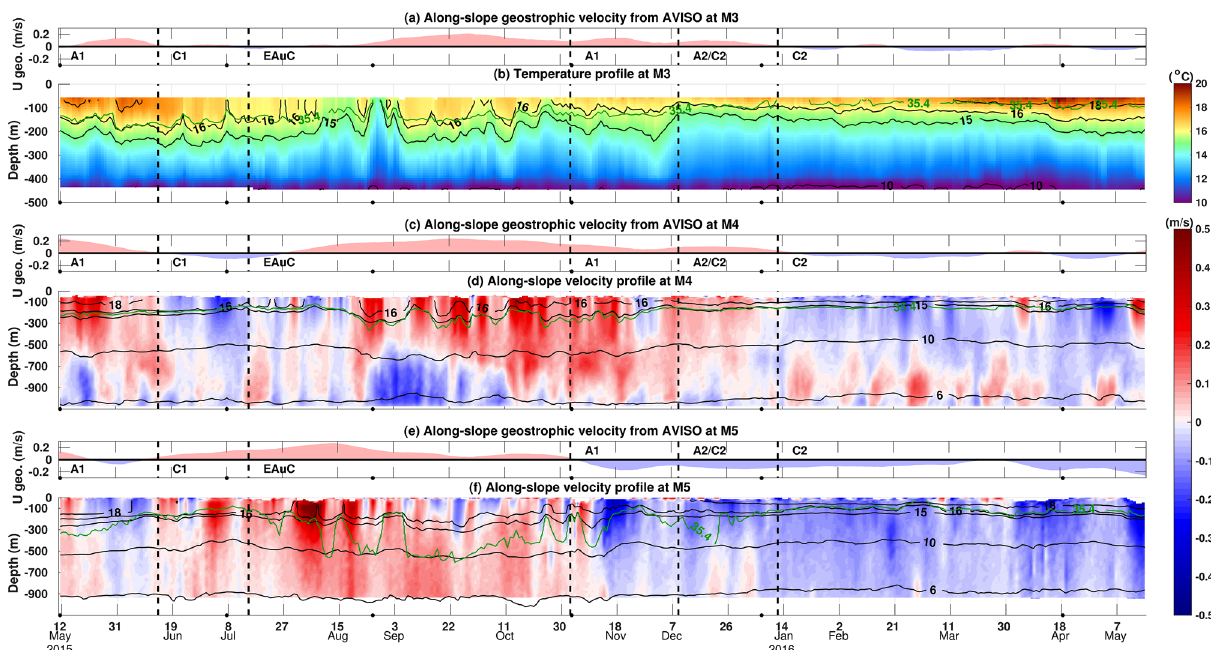
Figure 3. ( a ), ( c ), and ( e ) time series of along-slope geostrophic velocities from AVISO at M3, M4, and M5, respectively. Pink (positive value) indicates a southeastward current. The acronyms A1, C1, EAuC, A1, A2/C2, and C2 represent the presence of mesoscale structures (described in the text) at station M5. ( b ) Temperature daily average profile (shading), ( d ) and ( f ) along-slope daily average of velocities (shading), isotherms (black lines), and 35.4 g/kg isohaline (green line) are shown at M3, M4, and M5, respectively. The black dots mark the dates shown in Fig.